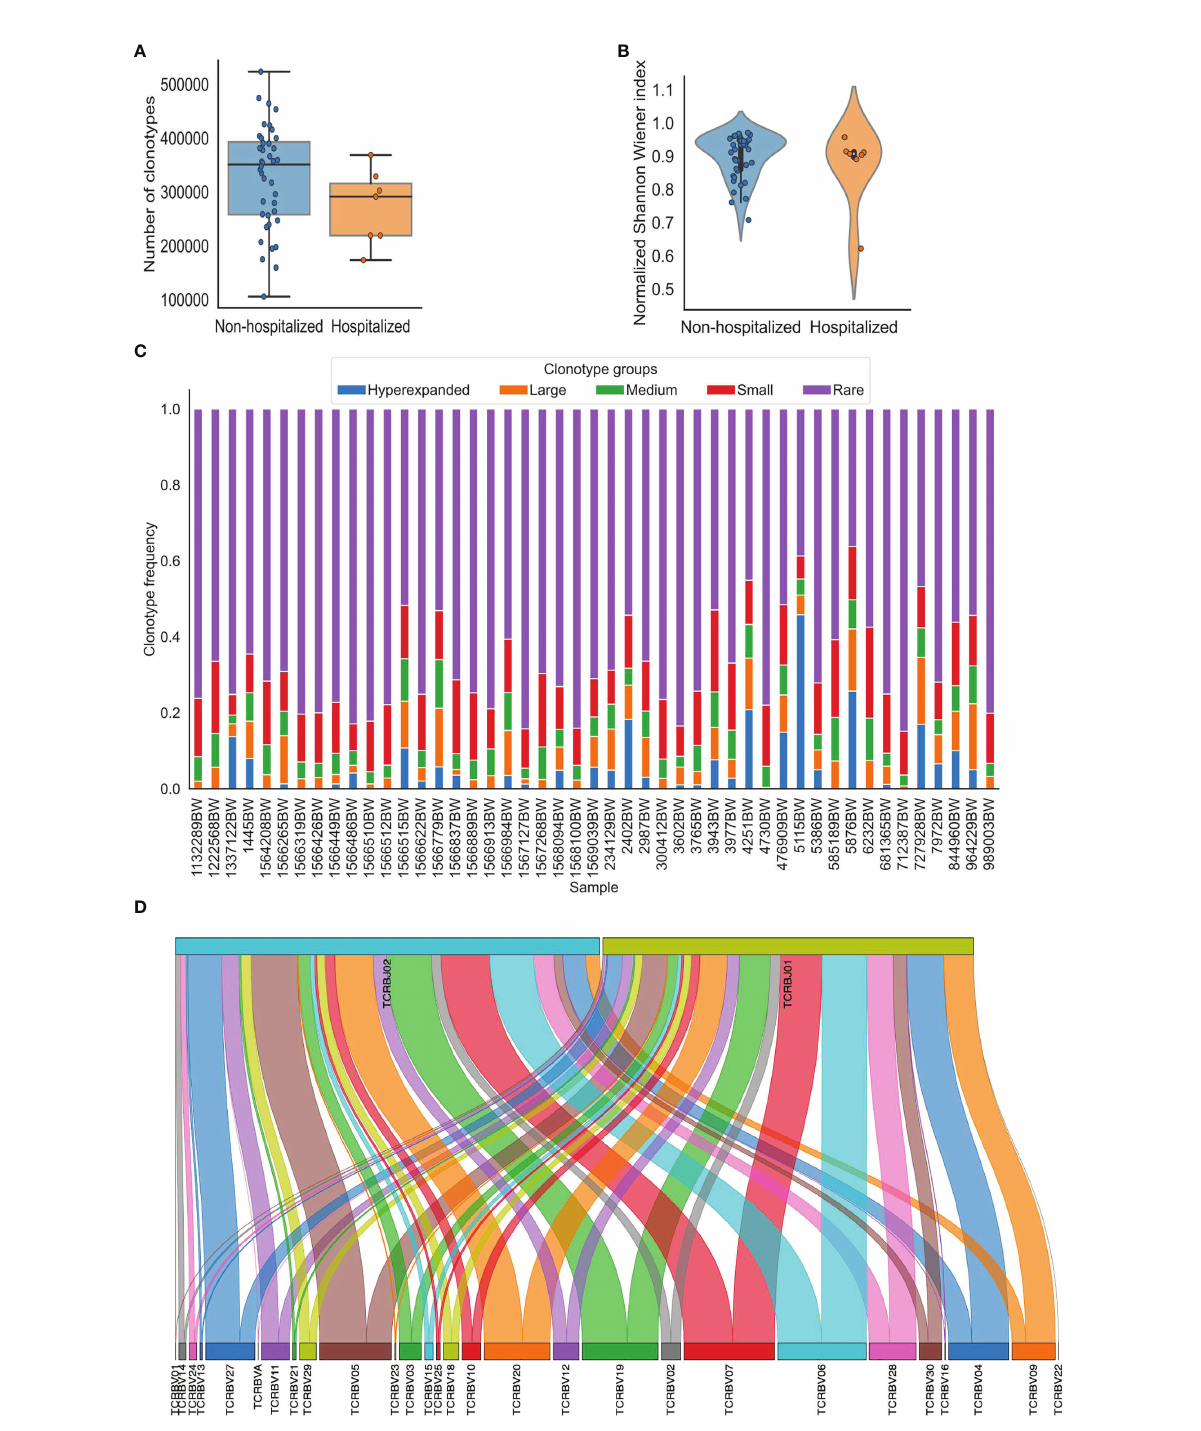
FIGURE 1 Visualization of TCR repertoire metrics generated using pyTCR. (A) The clonotype counts of each sample grouped by hospitalization status were presented as a box plot and strip plot. (B) The normalized Shannon-Wiener index of each sample grouped by hospitalization status was presented as a violin plot. (C) The distribution of clonotype groups in each sample was presented as a stacked bar plot. The clonotypes were categorized into fi ve groups based on the clonotype frequencies. Hyperexpanded clonotypes were the clones with frequencies between 0.01 to 1, large clonotypes were the clones with frequencies between 0.001 to 0.01, medium clonotypes were the clones with frequencies between 0.0001 to 0.001, small clonotypes were the clones with frequencies between 0.00001 to 0.0001, rare clonotypes were the clones with frequencies between 0 to 0.00001. (D) . The V-J combinations with V and J gene frequencies in sample 1445BW were presented as a Sankey